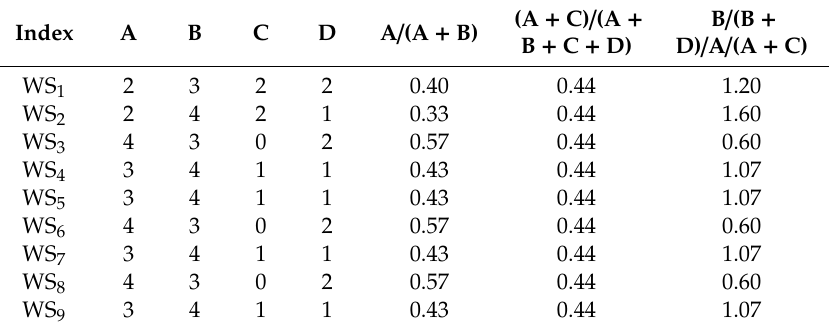
Table 6. Analysis of single EWSI values in Anhui Province.